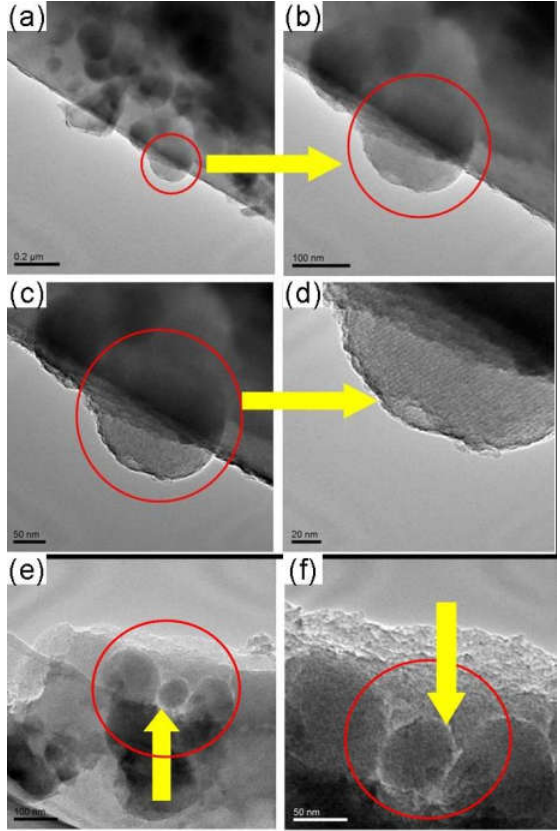
Figure 19. TEM images of the as-made MCM-48/C functional membranes [38]. Membranes 2018 , 8 , 134